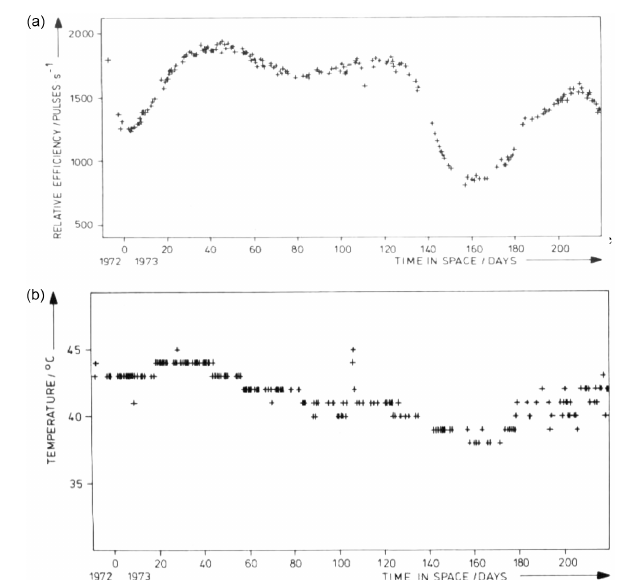
Figure 13. (a) Count rate changes of a Bendix MEM 306 multiplier using a nickel 63 radioactive β source (reprinted from Schmidtke et al., 1975; OSA copyright permission). (b) Trace of the temperature changes during the mission of AEROS-A to be compared with the count rate changes during the same time in Fig. 13a (reprinted from Schmidtke et al., 1975; OSA copyright permission).